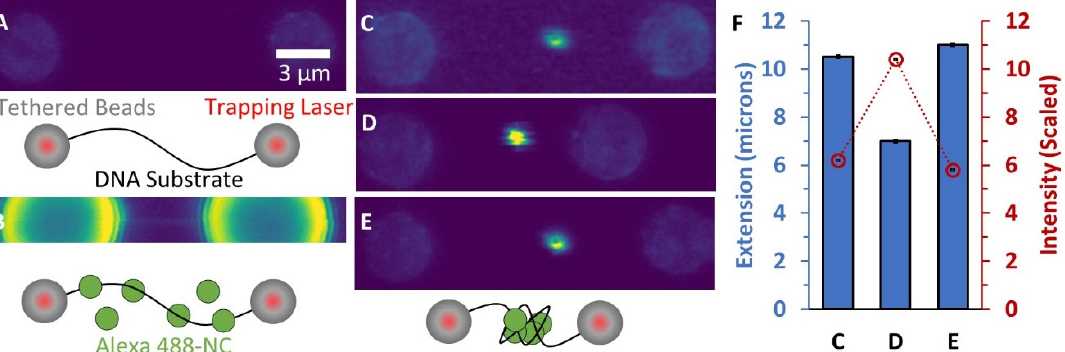
Figure 2. Binding of fluorescently-labeled NC to DNA. ( A ) Confocal scanning laser images (40 nm pixel size) and descriptive cartoons show two beads held by laser traps with an unlabeled DNA substrate tethered in between. The beads show weak autofluorescence and the DNA is not visible. ( B ) Alexa 488-NC is flowed into the sample chamber and binds the DNA (image magnification and brightness are enhanced to show faint line associated with NC binding uniformly along the stretched DNA). ( C ) When the DNA extension is decreased by bringing the two beads closer together, a large cluster of labeled NC forms along the substrate. The cluster becomes brighter when the substrate extension is further decreased ( D ) but becomes fainter again when extension is increased ( E ). ( F ) Quantification of the globule fluorescence intensity in each image compared to the substrate extension indicates that more labeled NC is incorporated into the globule as the end-to-end extension of the DNA is decreased. Error bars represent propagated error based on integration of pixel intensities associated with globule compared to background fluorescence.